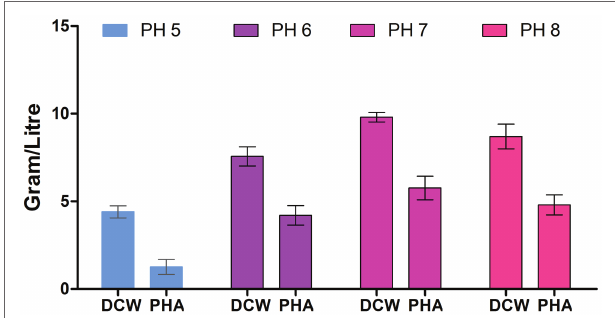
FIGURE 3 | Effect of pH on polyhydroxyalkanoate (PHA) production by P. aeruginosa EO1.